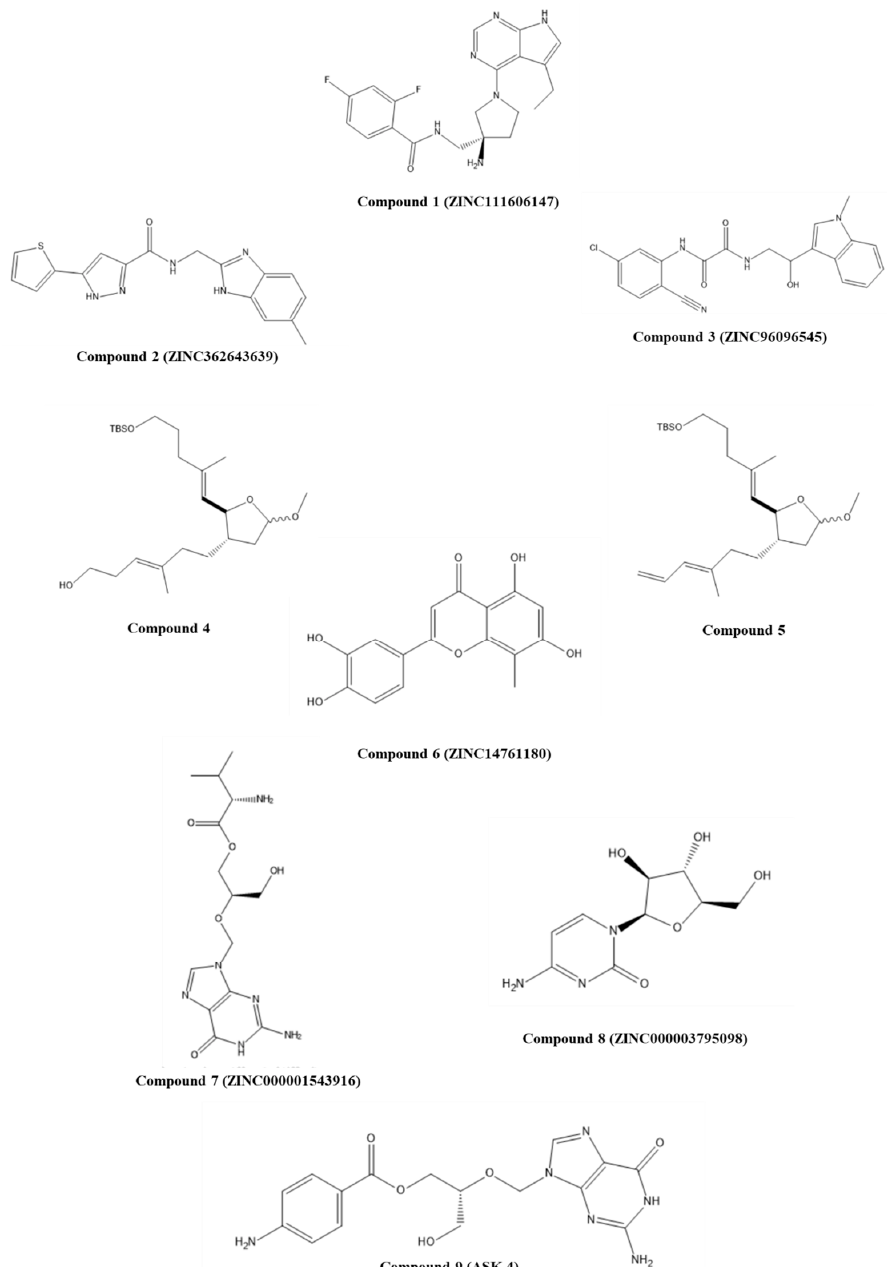
Figure 2. Structures of studied synthetic compounds as E6/E6AP inhibitors. IUPAC name of com ‐ pounds—compound 1 : ( S ) ‐ N ‐ ((3 ‐ amino ‐ 1 ‐ (5 ‐ ethyl ‐ 7 H ‐ pyrrolo [2,3 ‐ d ]pyrimidin ‐ 4 ‐ yl)pyrrolidin ‐ 3 ‐ yl)methyl) ‐ 2,4 ‐ difluorobenzamide; compound 2 : N ‐ ((6 ‐ methyl ‐ 1 H ‐ benzo[ d ]imidazol ‐ 2 ‐ yl)methyl) ‐ 5 ‐ (thiophen ‐ 2 ‐ yl) ‐ 1 H ‐ pyrazole ‐ 3 ‐ carboxamide; compound 3 : N 1 ‐ (5 ‐ chloro ‐ 2 ‐ cyanophenyl) ‐ N 2 ‐ (2 ‐ hy ‐